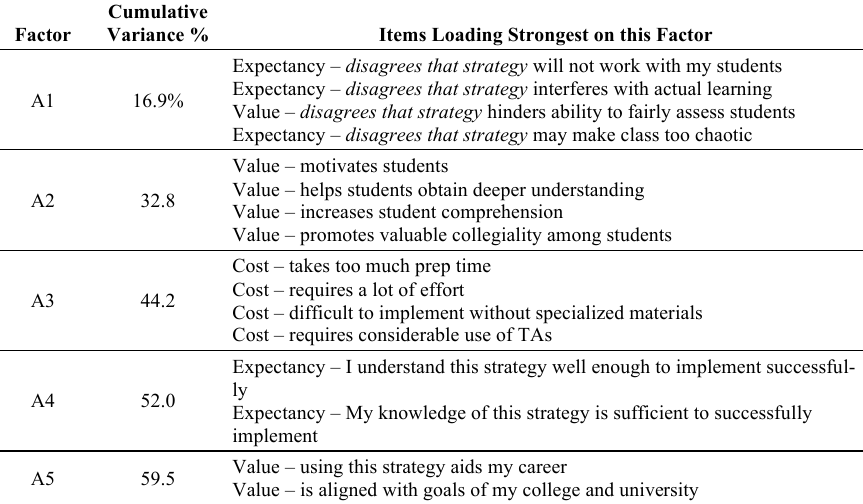
Table 5. Formative feedback, factor analysis